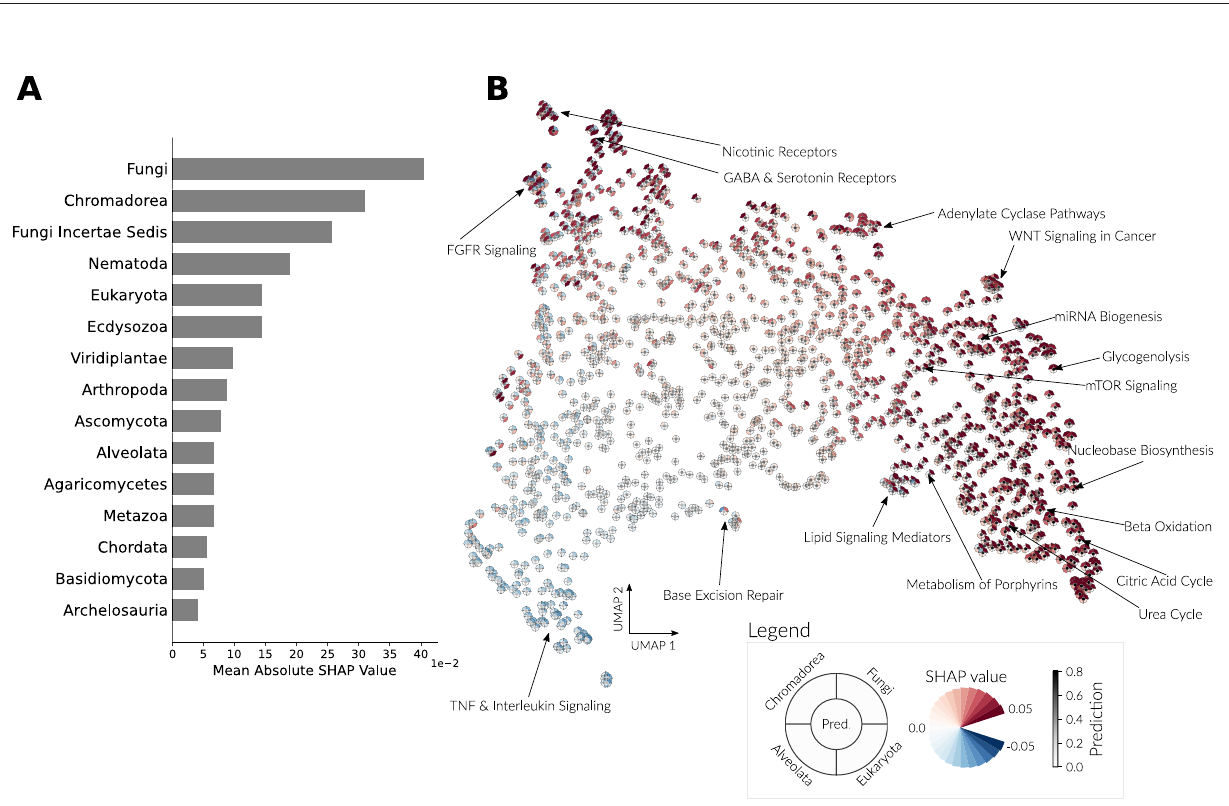
Fig. 6 Clade importance yields evolutionary insights. Clade importance by SHAP values was calculated for the test set of a single cross-validation in the functional interaction model, revealing the clades with the highest mean absolute importance ( A ). Clade importance was averaged for each Reactome pathway and projected into two dimensions using UMAP ( B ). For each pathway, a marker is shown with the average SHAP value for one of four speci fi c clades by the color of a quarter of the marker. The average predicted probability across gene pairs is shown by the color of the circle in the middle. Source data are provided as a Source Data fi